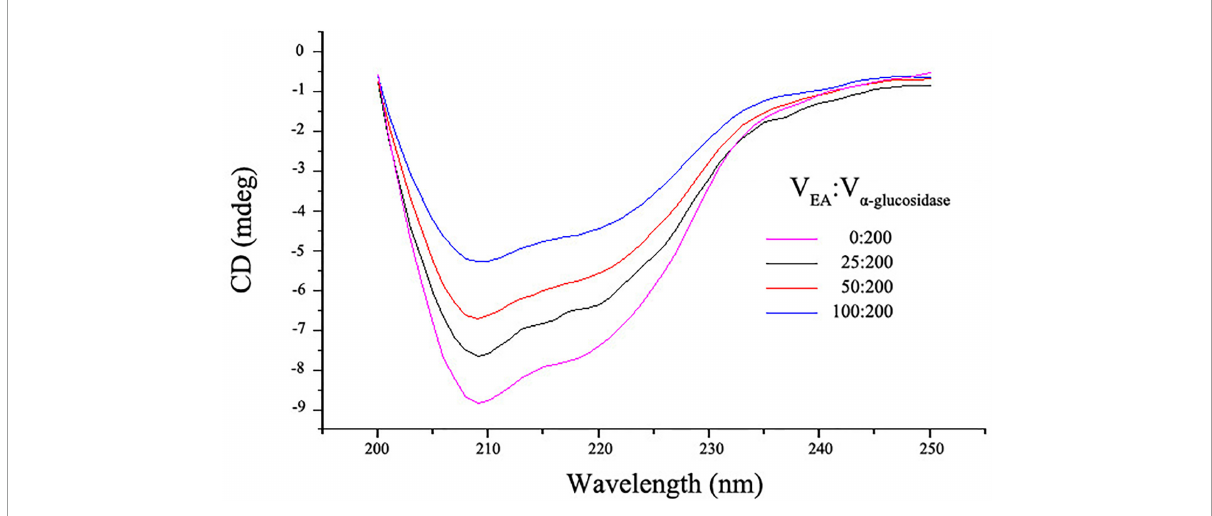
FIGURE4 The CD spectra of α -glucosidase with or without different volumes of EA. 200 µ L of α -glucosidase (5.0 U/mL) mixed with different volumes (0, 25, 50, and 100 µ L) of EA (2 mg/mL) and the CD spectra was determined. The spectrum scanning range was between 200 and 250 nm.